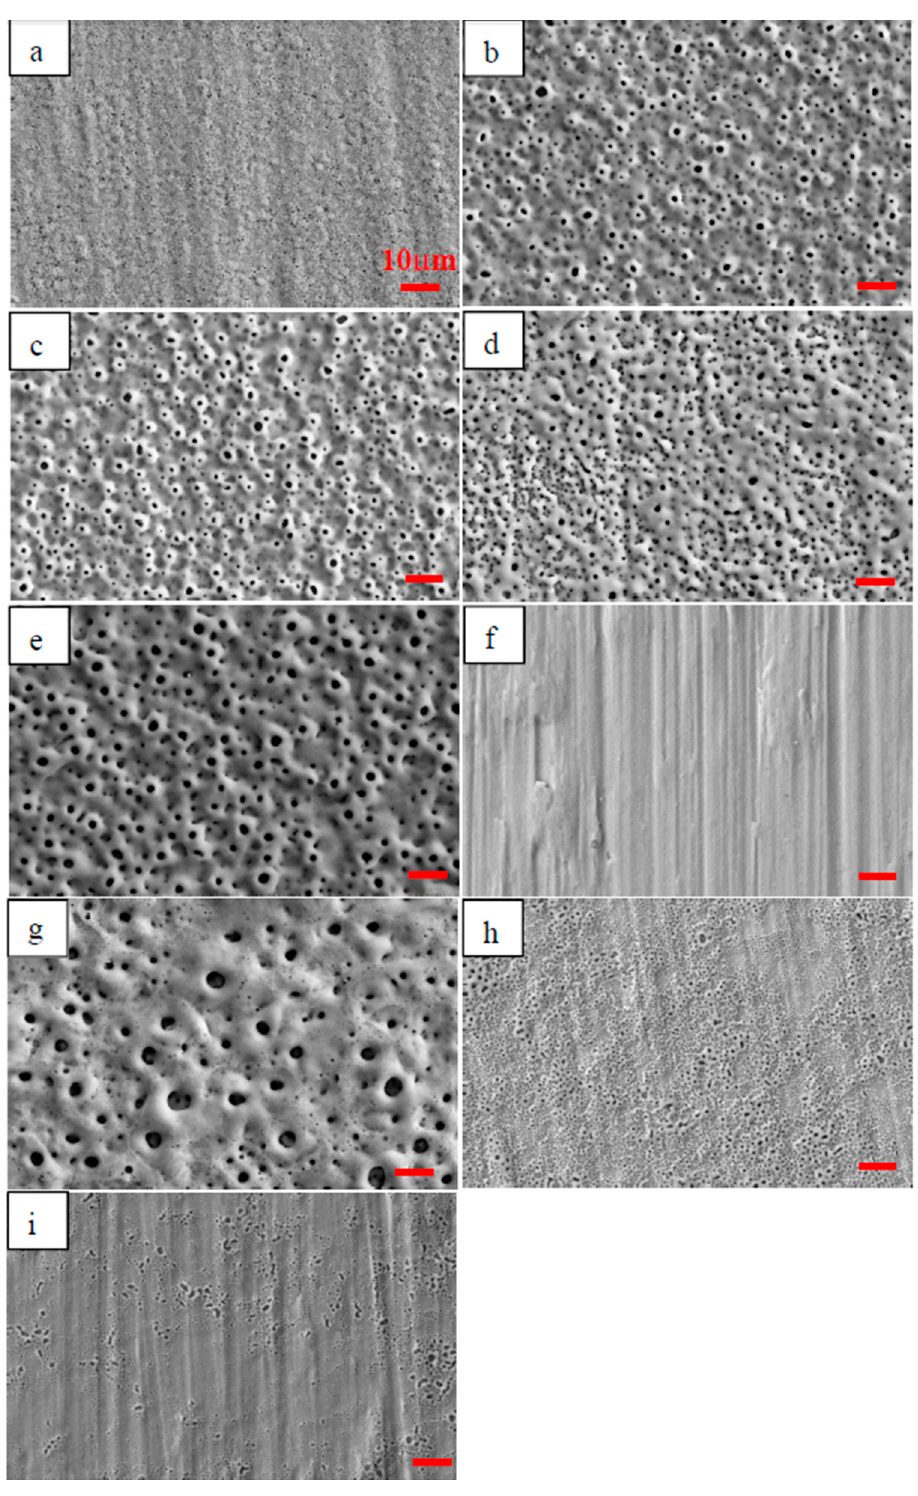
Figure 4. Surface morphologies of micro-arc oxidation (MAO) coatings developed under different processing parameters: ( a ) No. 1, ( b ) No. 2, ( c ) No. 3, ( d ) No. 4, ( e ) No. 5, ( f ) No. 6, ( g ) No. 7, ( h ) No. 8 and ( i ) No. 9.